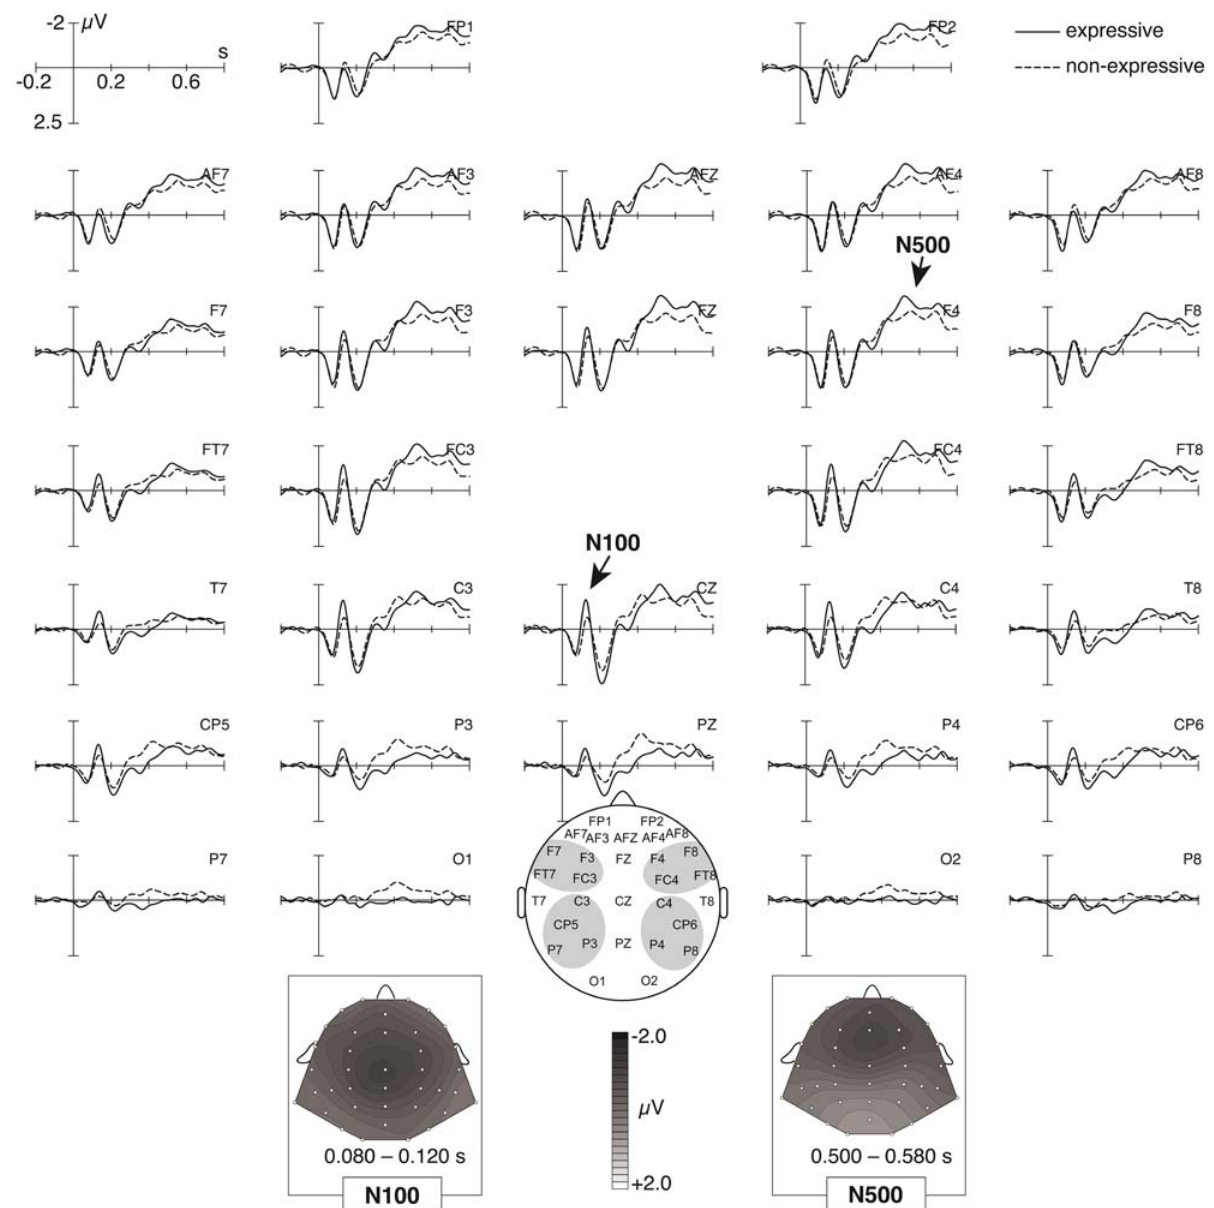
Figure 5. Grand-average of brain electric responses to expressive and non-expressive chords (averaged across expected, unexpected, and very unexpected conditions). Expressive chords elicited a negative effect in the N100-range (being maximal at central electrodes), and an N5 that was larger than the N5 elicited by non-expressive chords. The bottom insets show isopotential maps of the N1 and N5 effect (non-expressive subtracted from expressive